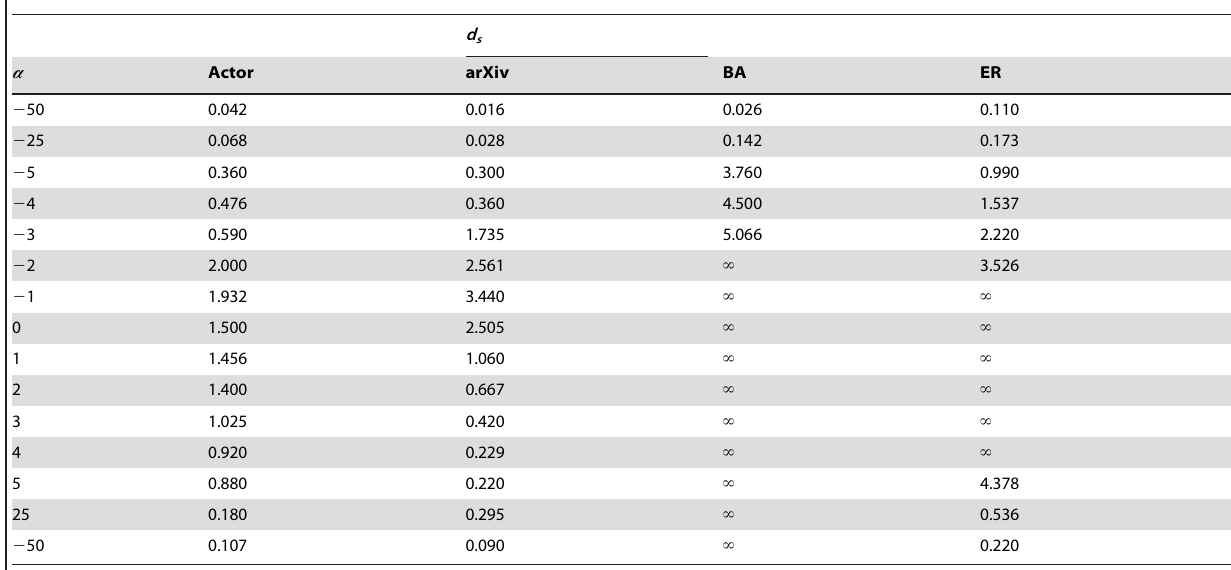
Table 3. Spectral dimension d s w.r.t. weighting factor a .